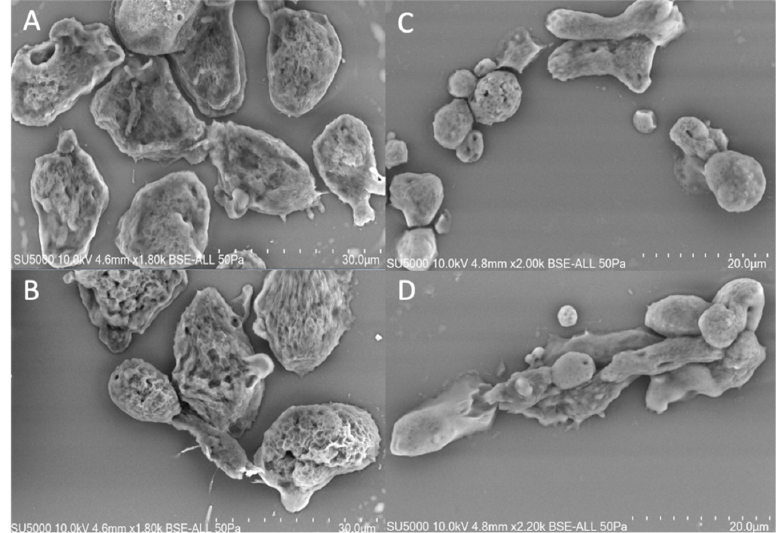
Figure 1. Morphology of Willaertia magna cultivated under two different culture conditions. In ( A , B ): W. magna is cultivated in adhesion on cell culture flask. In ( C , D ): W. magna is cultivated in suspension in bioreactor. Pictures were obtained with emission Scanning Electron Microscope SU5000 (Hitachi, Japan). Bar scales are represented on picture.